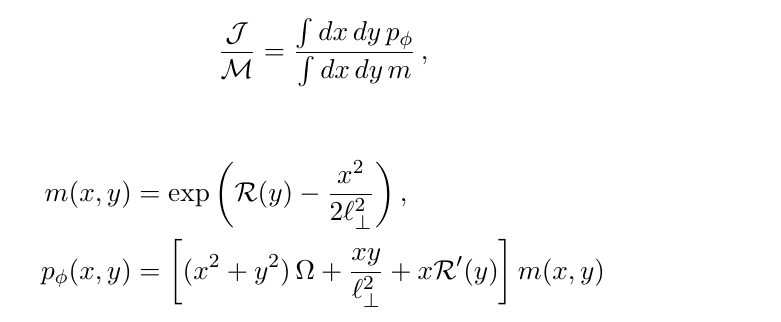
Figure 13 . The 10 (cid:12)rst dumbbell branches, we also plot the branching points of the odd bar perturbations marked by points that only give rise to short ‘spindle’ branches.The Myers-Perry solutions are represented by the thick black curve, and the (non-deformed) black bars by the thick red curve. Di(cid:11)erent tones of green are being used for di(cid:11)erent branches for the sake of clarity. The angular momentum per unit mass is calculated using eqs. (2.25) and